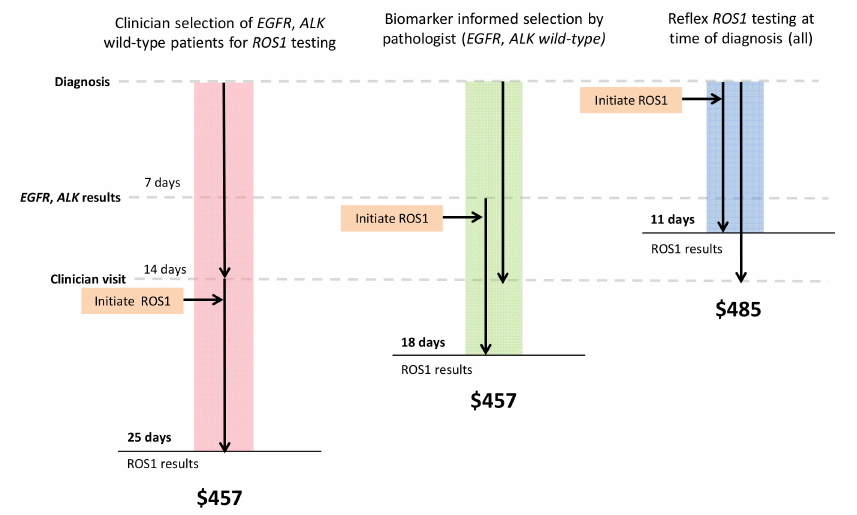
Figure 3. IHC screening with FISH confirmation most cost-efficient. Color bars represent the three strategies that are most cost-efficient in each arm of the model (clinician-initiated, biomarker- informed, and reflex testing). Black arrows demonstrate the time at which ROS1 testing is initiated. Result turnaround time and estimated costs are